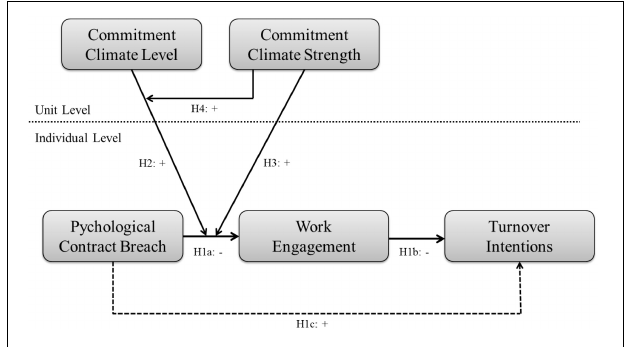
FIGURE 1 | Research